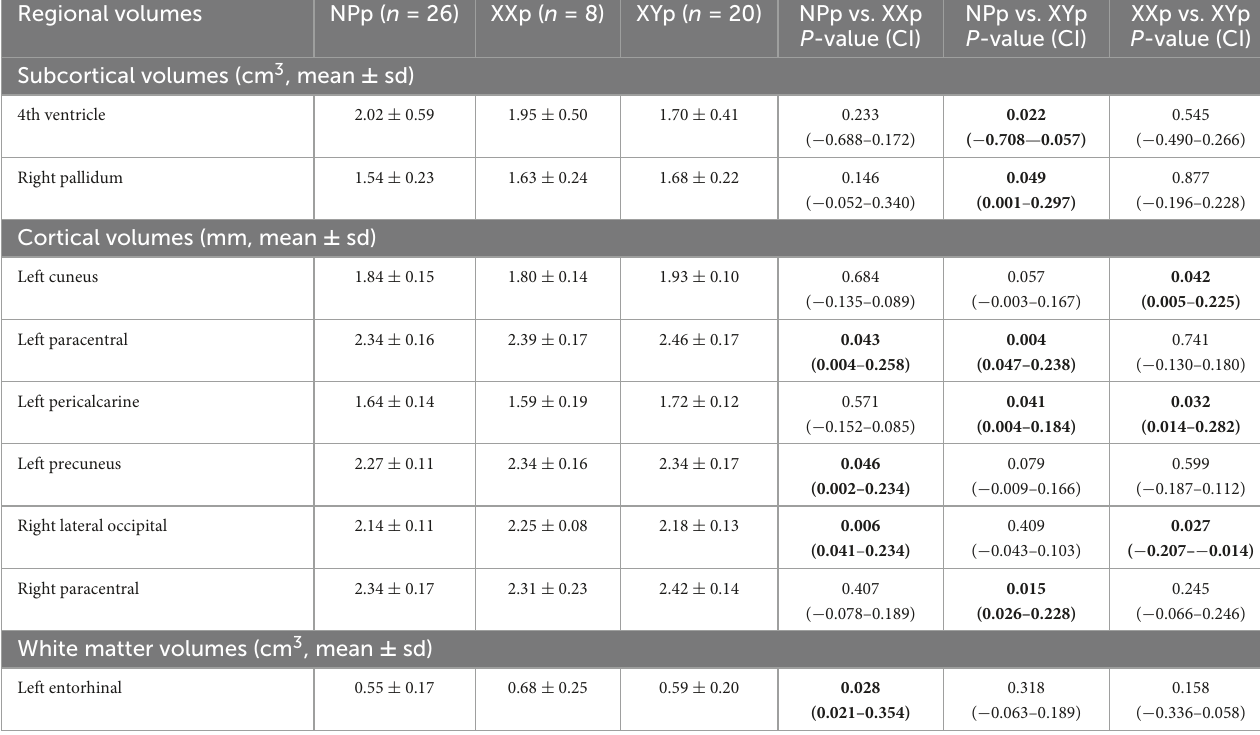
TABLE 6 Radiological data for regional